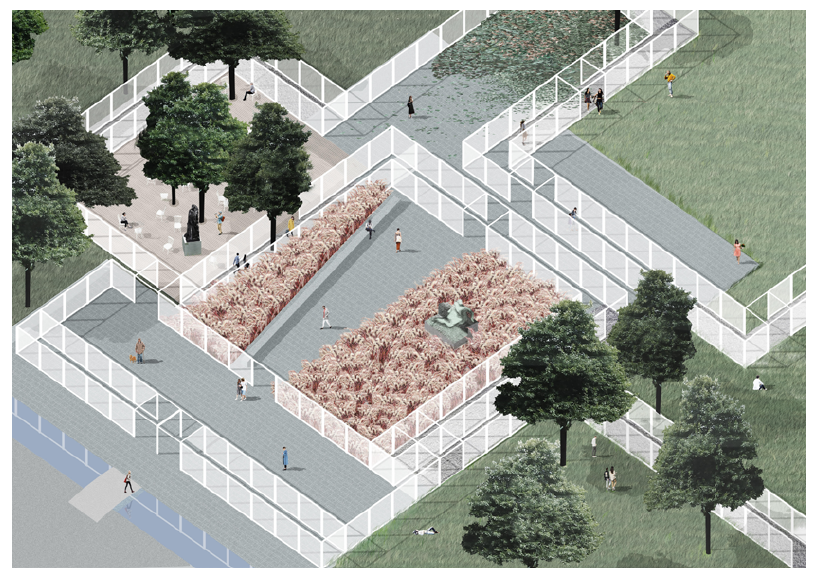
FIG. 8 Retallack Thompson and Other Architects, 2017 NGV Architecture Commission, Garden Wall, National Gallery of Victoria, Melbourne. Source: Retallack Thompson and Other Architects and NGV